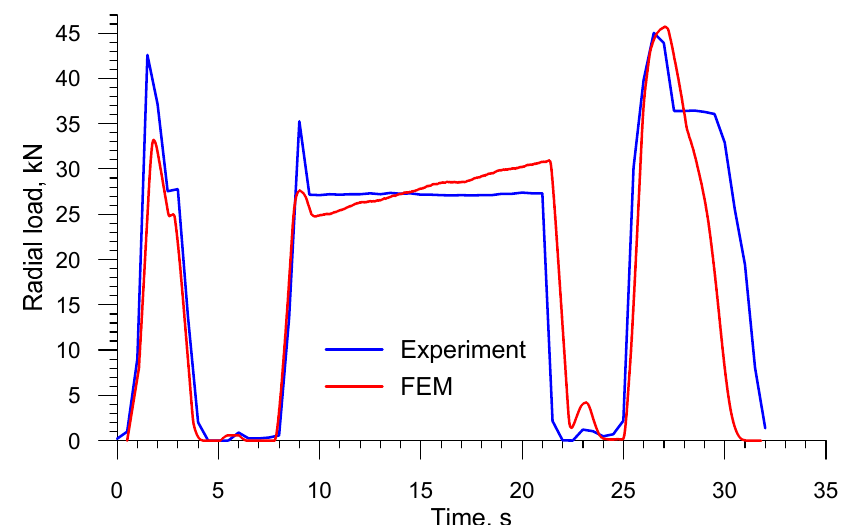
Figure 27. Comparison of the FEM and experimental radial loads in skew rolling railway axles in a 3-roll mill (1:5 scale).